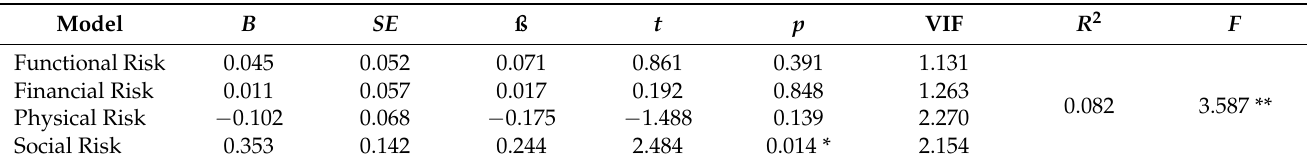
Table 6. Results of multiple regression using perceived risk to predict COVID-19 quarantine ser- vice quality.